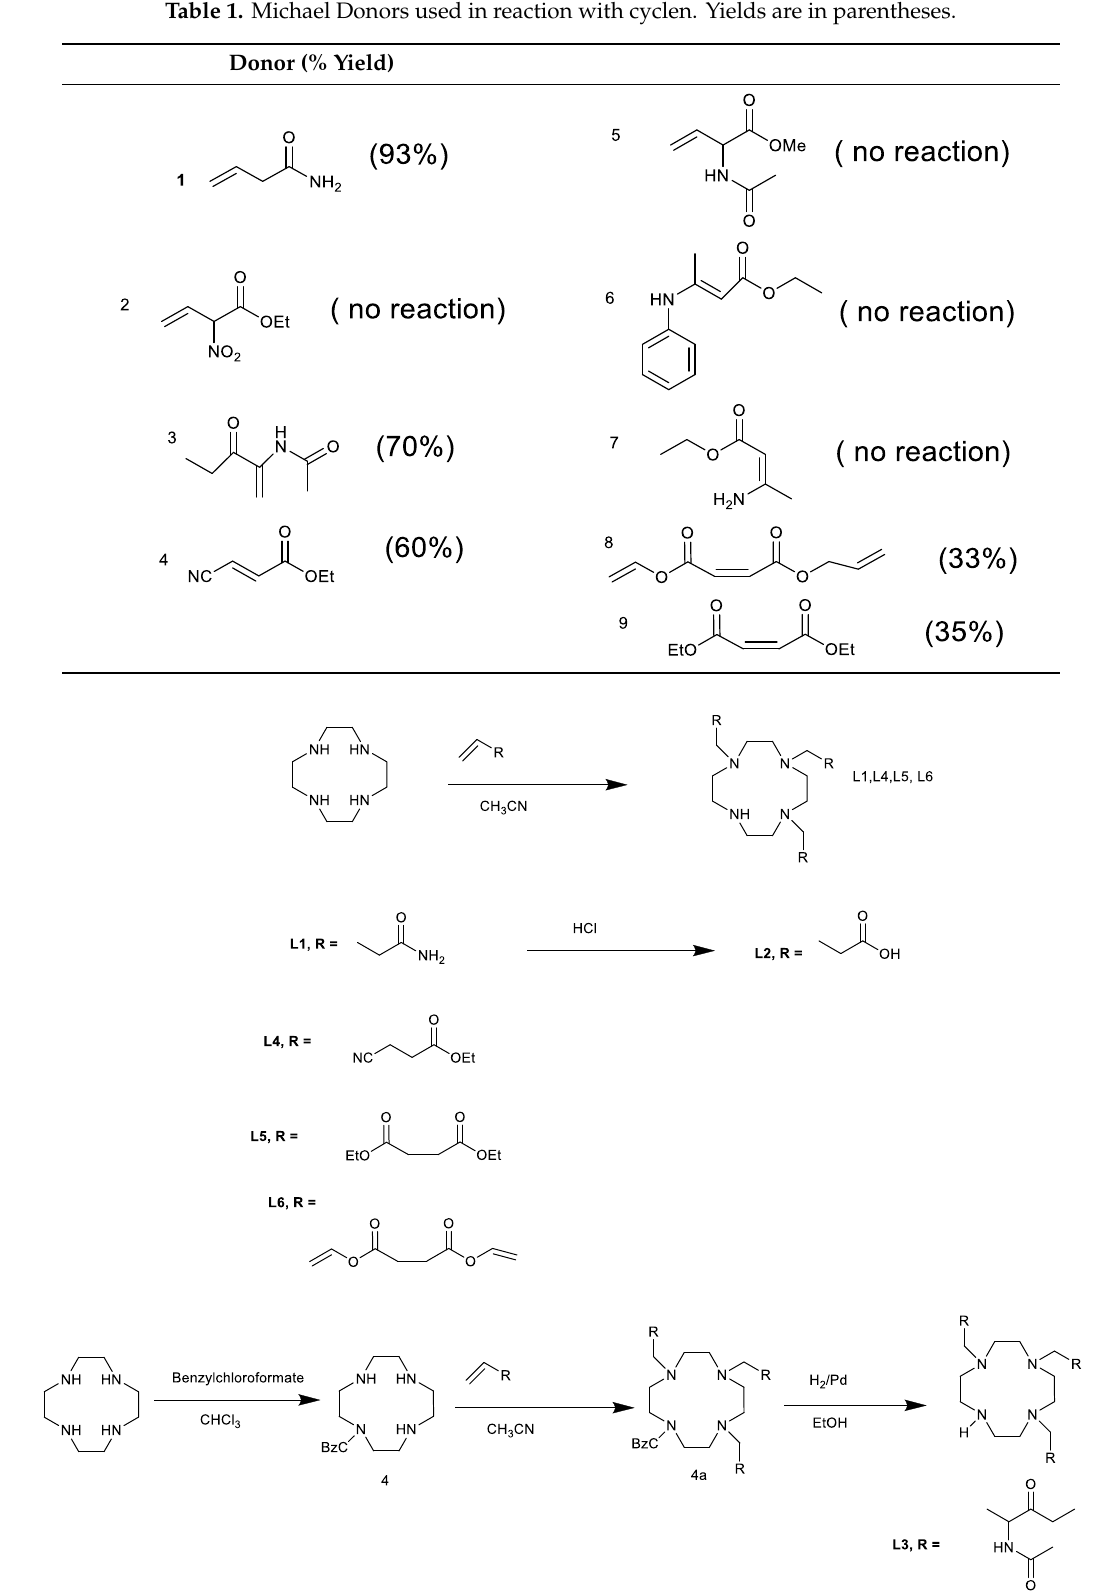
Table 1. Michael Donors used in reaction with cyclen. Yields are in parentheses.